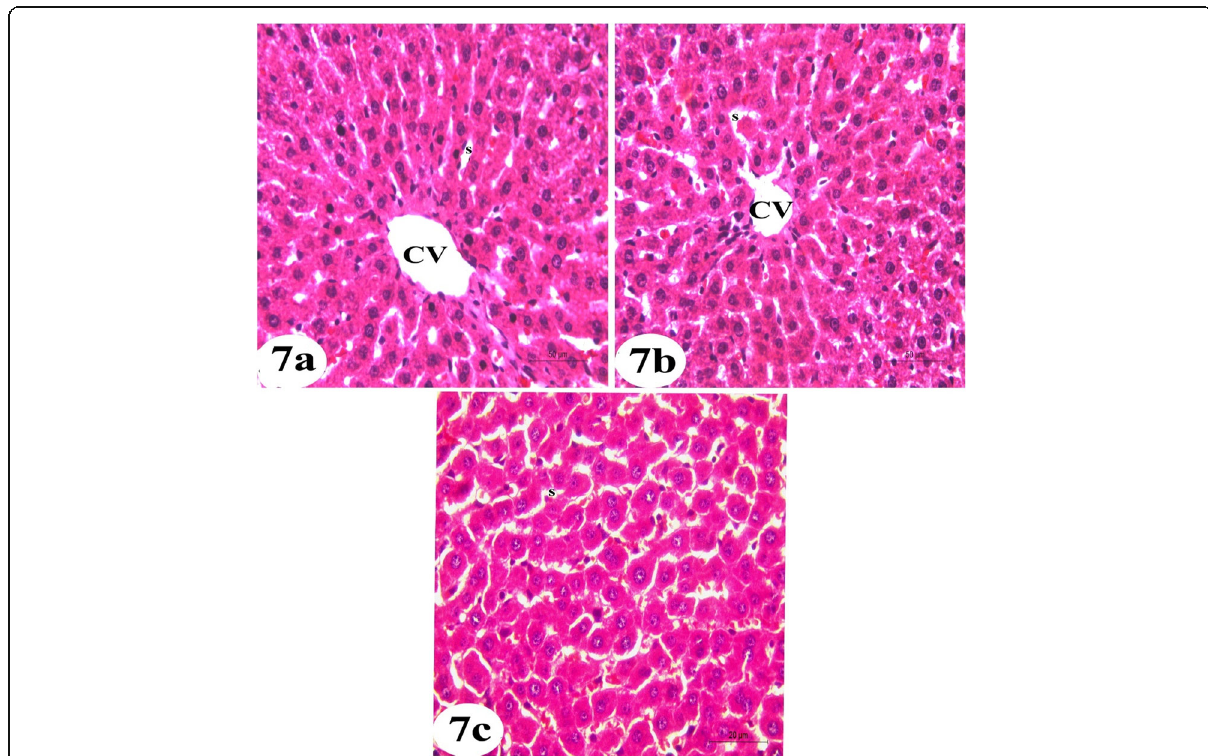
Fig. 7 Photomicrographs of sections of liver of a control rats and b , c ginseng groups, treated with 100 and 200 mg/kg b. wt./day respectively, stained with H&E: showing normal histological structure of liver; radially arranged polyhedral hepatocytes forming cords around the central vein (CV) and sinusoids (S) (scale bar = 50 μ